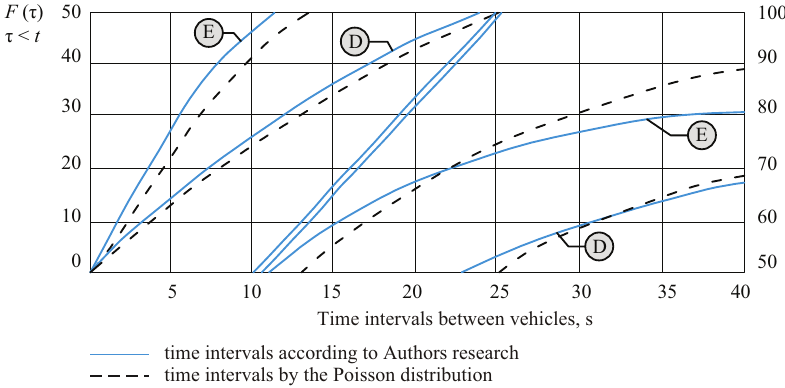
Figure 9. Comparison of the distribution functions of time intervals between vehicles obtained from studies on Bridges D and E with distribution functions derived theoretically from the Poisson